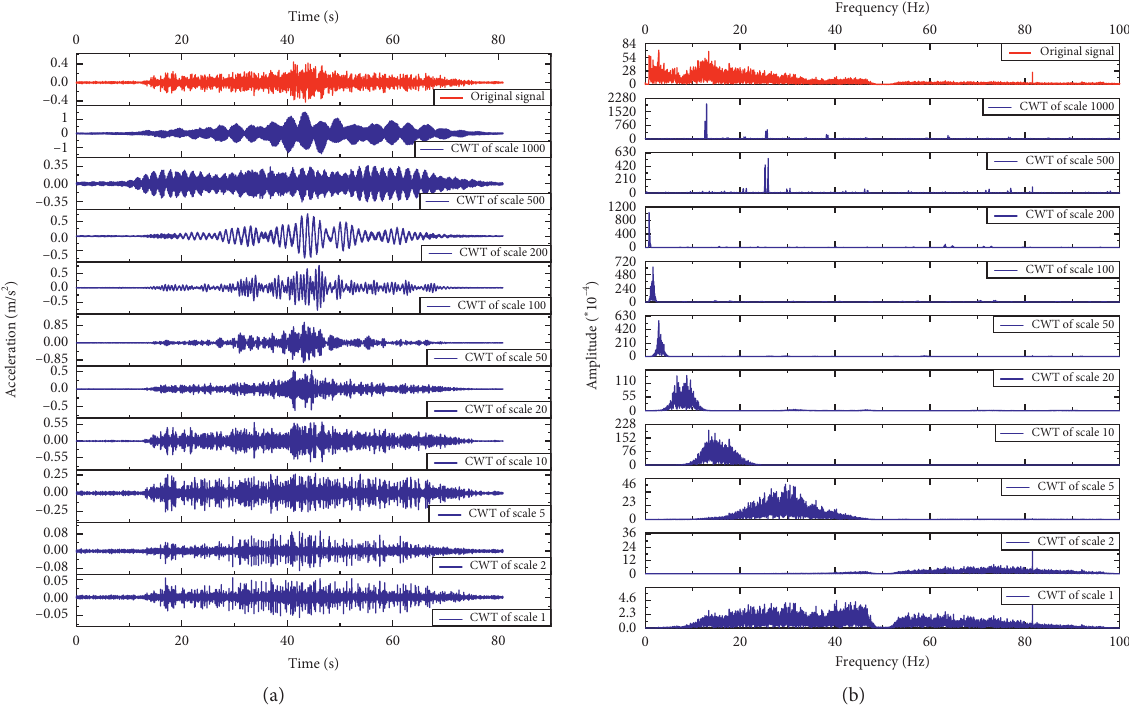
Figure 16: CWT analysis of XA2 at the crown of the under-crossing tunnel at different scales: (a) time history; (b) Fourier spectrum. Table 7: Peak acceleration and frequency of the crown at the central cross section of the under-crossing tunnel. Transformation